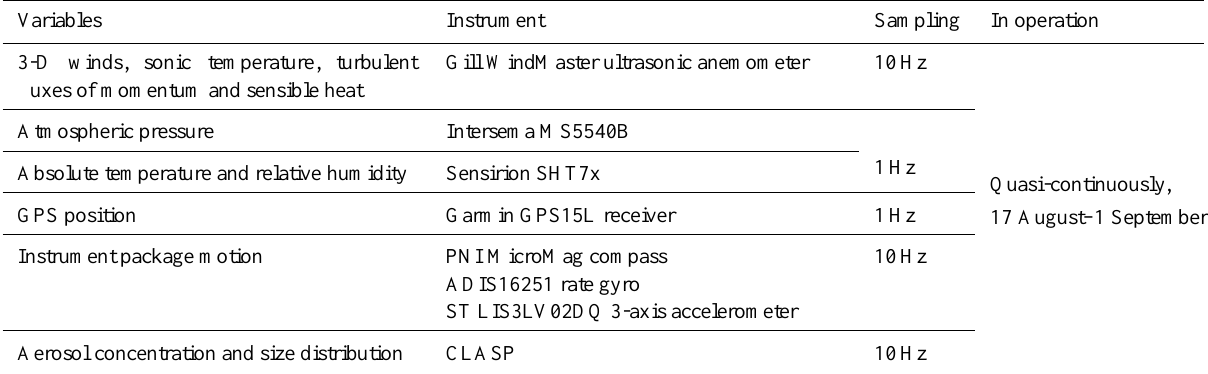
Table A4. List of instruments for the tethered sounding package. This package was operated semi-continuous, weather and manpower permitting, and operated from the surface up to 500m; 77 individual flights were made totaling 210h of